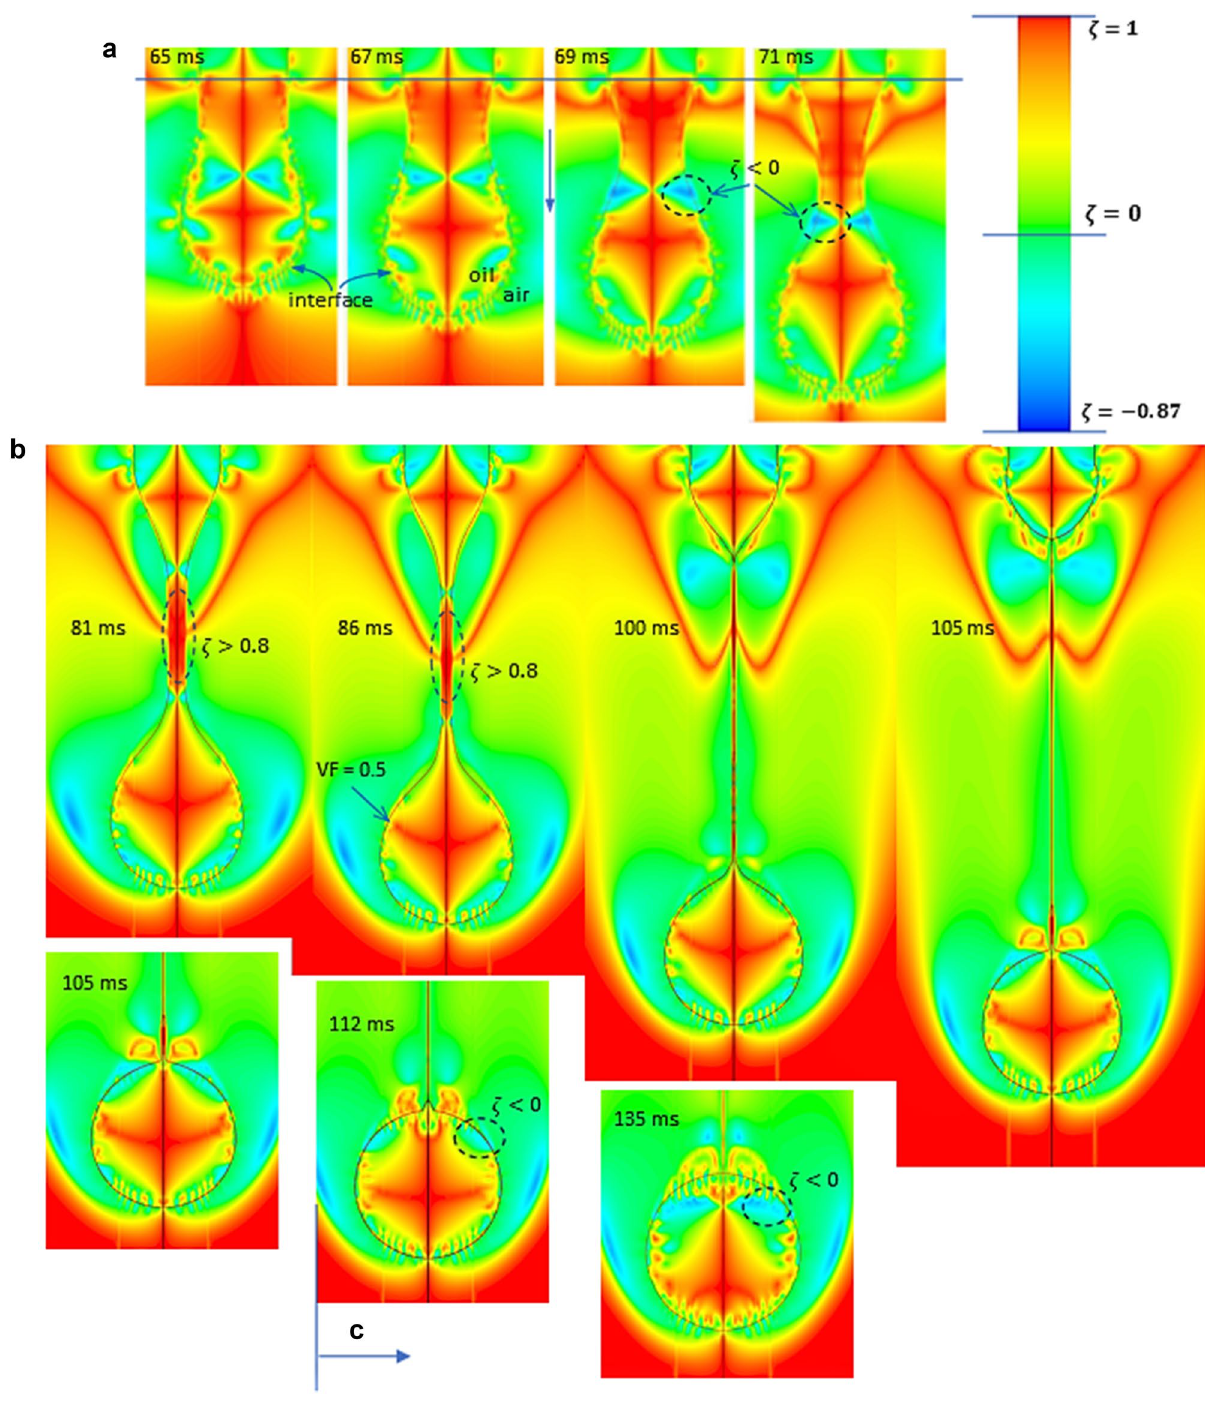
Figure 5. Distribution of ζ -coefficient in the droplet and in its vicinity: TR-regime ( a ), VR (linear)-regime ( b ), post pinch-off ( c ). It is important to remark that vorticity dominant regions ( ζ < 0) inside the droplet are almost absent in the VR regime ( b ), where extension is dominant (especially in the